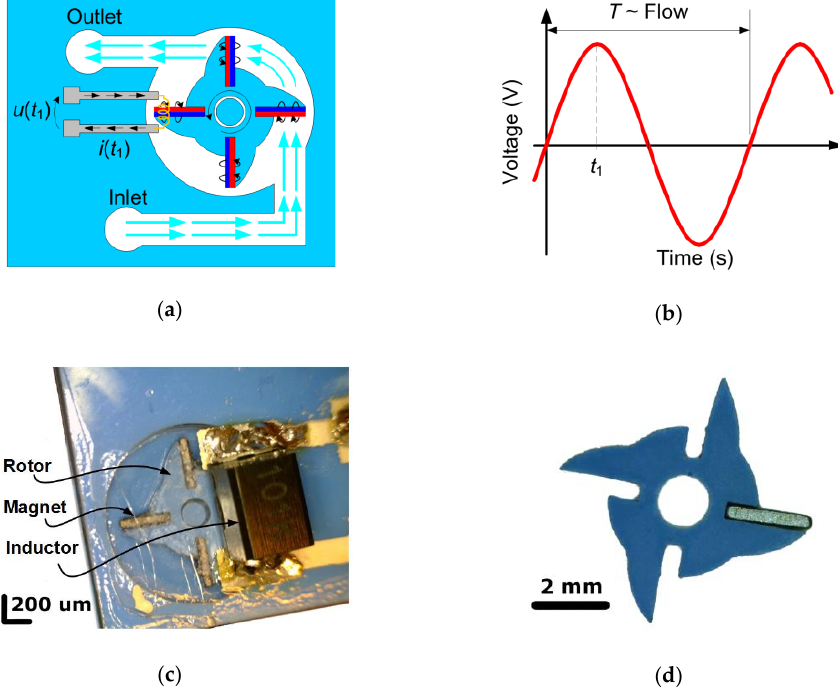
Figure 2. Electromagnetic flow sensor: ( a ) Principle of operation; i ( t x ), u ( t x ) current and voltage across the inductor; ( b ) Ideal waveform of output signal; T —period; t —time; ( c ) Flow sensor technological implementation; ( d ) Shape of turbine’s rotor.